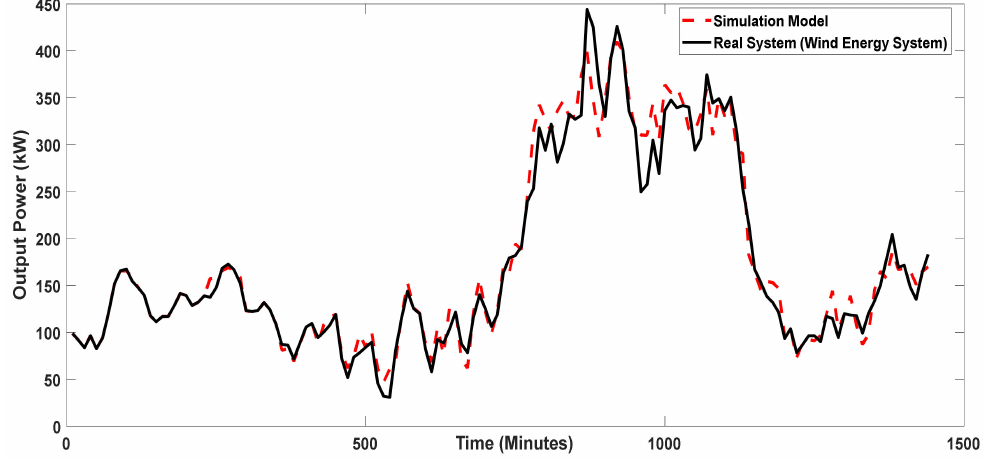
Figure 5. Measured and simulated wind turbine generator